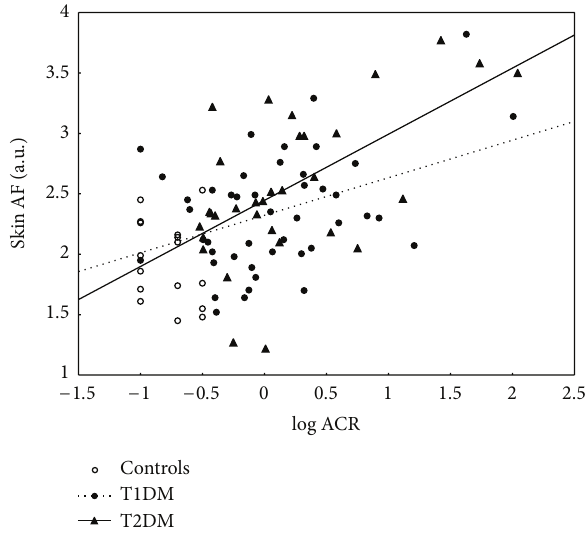
Figure 1: Relationship of skin AF and albuminuria expressed by ACR in controls, T1DM, and